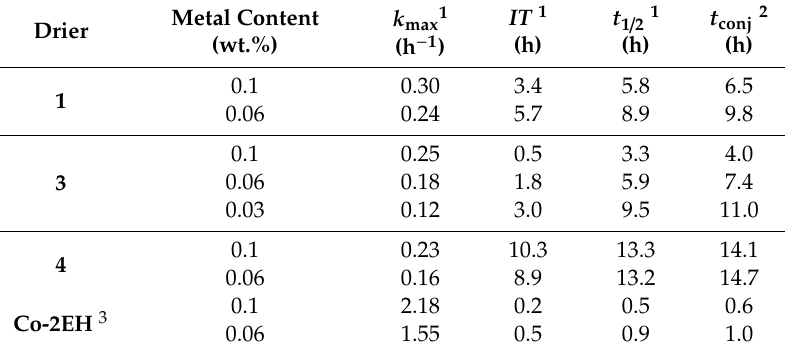
Table 5. Kinetic parameters for ferrocene derivatives.